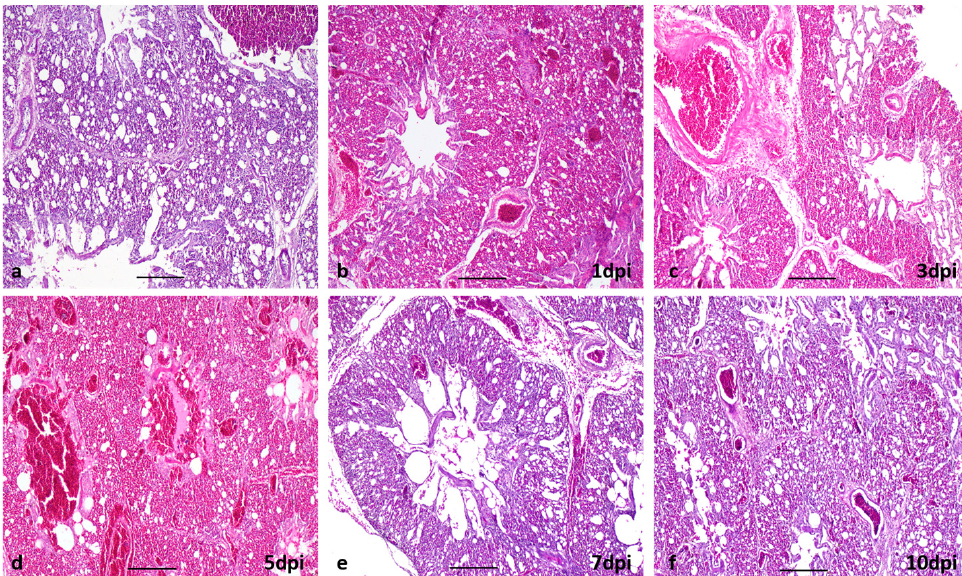
Figure 4. Section of lung of chickens ( a ) uninfected, no lesions, ( b – f ) infected with LPAI, ( b ), mild congestion, ( c ) congestion with edema, ( d ) severe congestion, edema and collapsing of alveoli, ( e , f ) almost normal appearance of lung, comparable to control ( a ). H & E stain, bar: ( a – d , f ) = 50µm; ( e ) = 20µm .